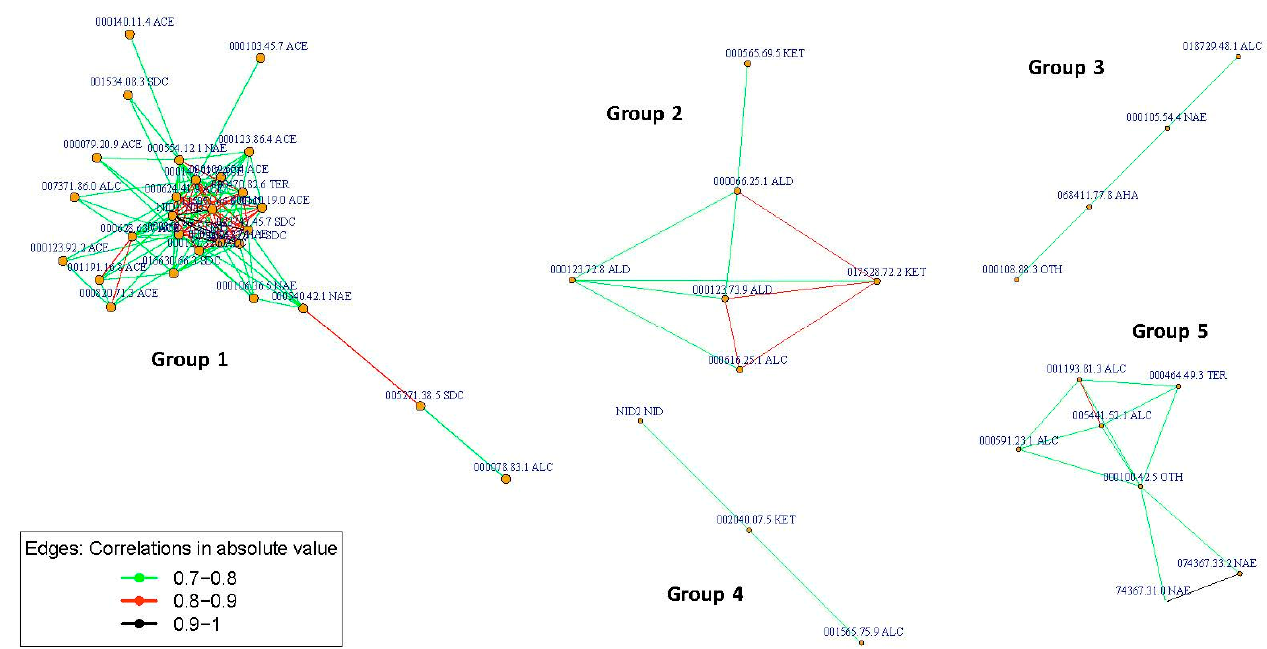
Figure 5. Grouping of individual volatile compounds with six or more compounds in each group obtained by correlation network analysis (CNA) applied to individual volatile compounds analyzed for Near-Isogenic Lines (NILs) with introgression on melon chromosome 3 (SC3-5-7, SC3-5-8, SC3- 5-12, SC3-5-13, and SC3-5-14) and the parental control ‘Piel de Sapo’ (PS). CAS numbers use dots instead of dashes. ACE, acetate esters; NAE, non-acetate esters; SDC, sulfur-derived compounds; ALD, aldehydes; KET, ketones; ALC, alcohols; TER, terpenes; AHA, aliphatic compounds; OTH, other compounds; NID, unidentified compound. Table 5. Groups with at least two compounds and correlations above 0.7 in absolute value were obtained by correlation network analysis (CNA) applied to melon aroma volatile compounds. The chemical and sensory attributes of the compounds are in Table S6.